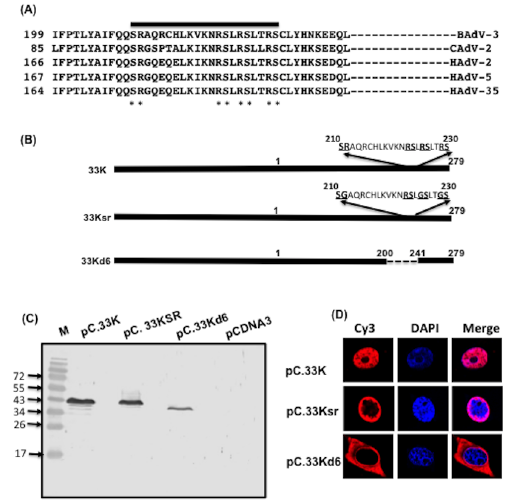
Figure 4. In-vitro nuclear import assays. MDBK cells were permeabilized with digitonin and incubated with ( A ) GST-NLS-GFP (panels a,b,c,d,e,f,g,h,I,j) or ( B ) GST-33K (panels a,b,c,d,e,f,g,h,I,j). Import reactions were carried out in the presence (panel a) or absence of rabbit reticulocyte lysates (panel b), absence of ATP generating system (panel c), in the presence of the dominant negative mutant RanQ69L (panel d), in the presence of wheat germ agglutinin (WGA) (panel e), incubation at 40C (panels f), in the presence of inhibitory peptides IBB Imp a (panel h), IBBrpL23 a (panel g) Ycbp80 (panels i), SR1 (panel j).